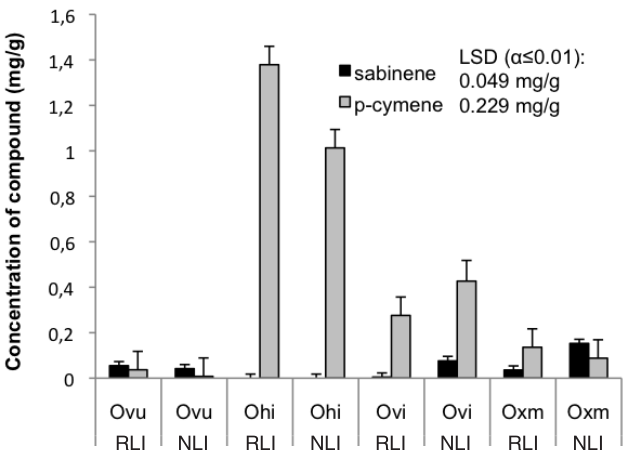
Fig. 1: Effects of accession and light intensity on the chemical compounds of essential oil in herb samples (s.e.: mean standard error of mean, Ovu: Origanum vulgare ssp. vulgare , Ohi: Origanum vulgare ssp. hirtum , Ovi: Origanum vulgare ssp. viride , Oxm: Origanum vulgare ssp. viride × majorana ), RLI: reduced light intensity, NLI: normal light